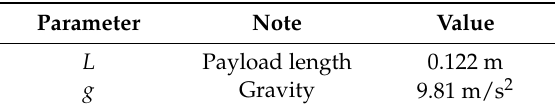
Table 1. Model parameters.